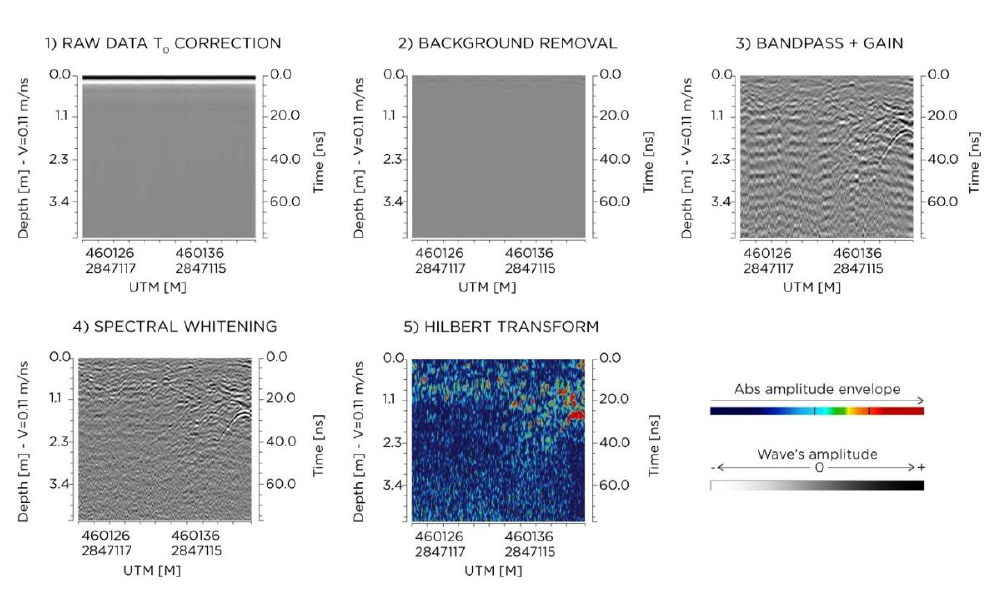
Figure 9. Example of processing step effects on a single radargram.